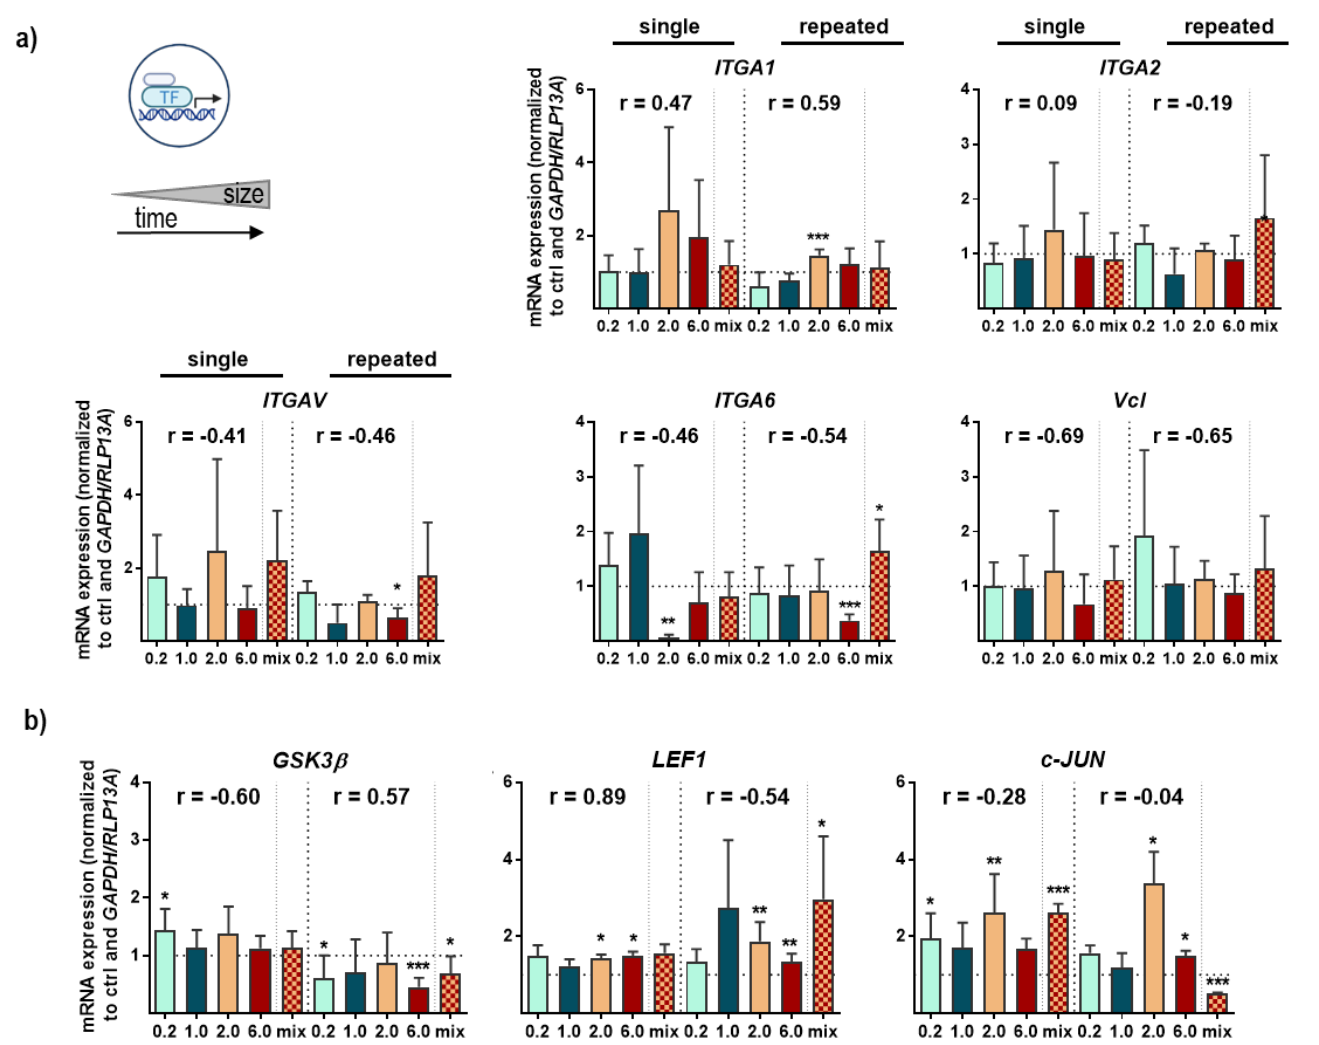
Figure A2. ( a , b ) Study scheme (top) and expression values of ITGA1, ITGA2, ITGAV, ITGA6, and VCL ( a ) and GSK3 β , LEF1, and c-JUN ( b ) were quantified using qPCR after single and repeated NMP exposure. Data were normalized to GAPDH/RLP13A and untreated controls (ctrl) and presented as mean + SE. Statistical analysis was done by unpaired, two-tailed Student ’ s t-test with * p < 0.05, ** p < 0.01, and *** p < 0.001.